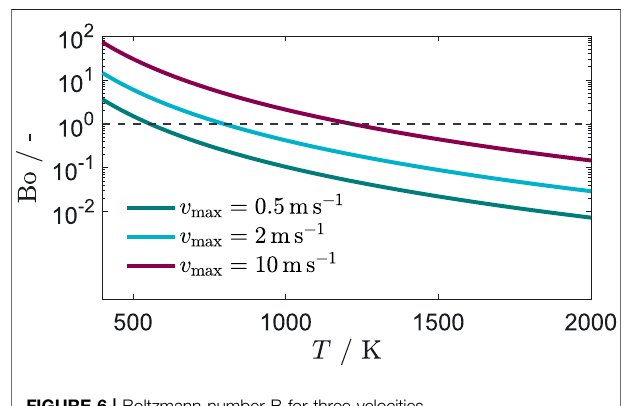
FIGURE 6 | Boltzmann number B for three velocities ] ∈ { 0 . 5 , 2 , 10 } max